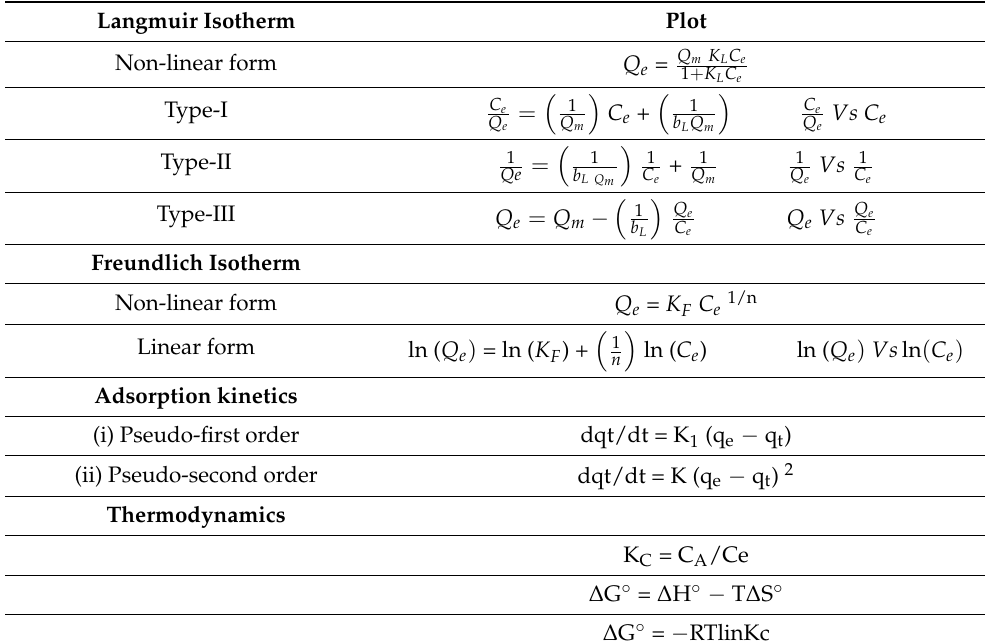
Table 1. Equilibrium modelling